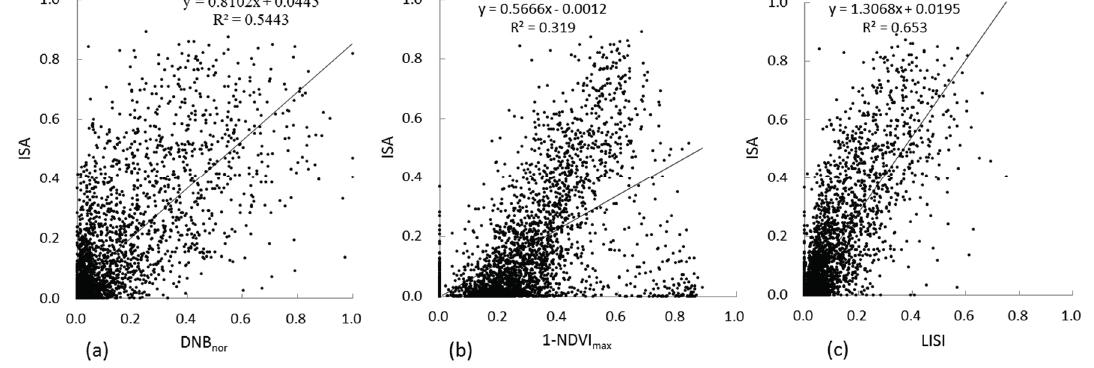
Figure 5. The relationships between reference ( a ) ISA and DNB nor , ( b ) ISA and 1-NDVI max , and ( c ) ISA and